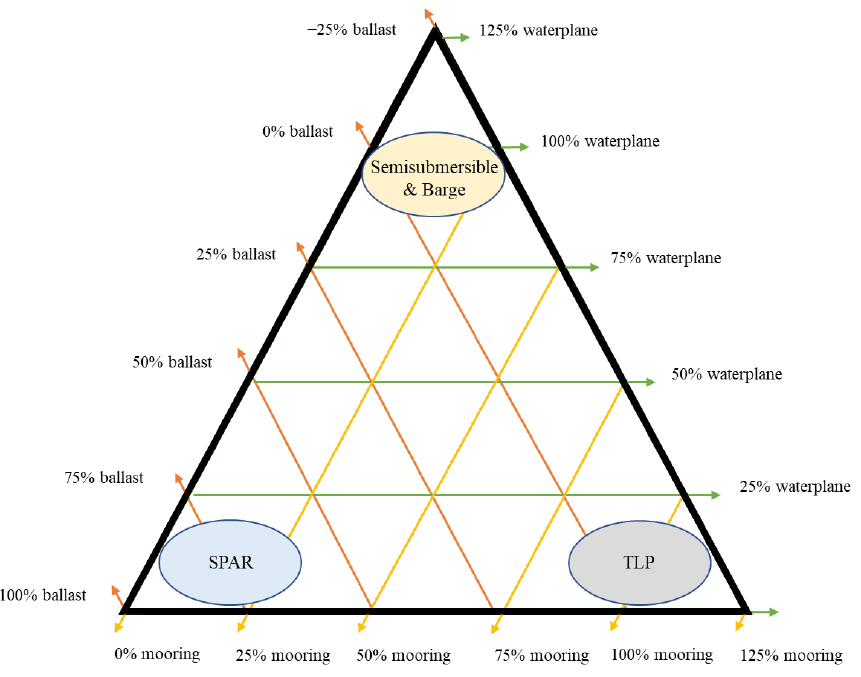
Figure 1. Floating foundations stability triangle.